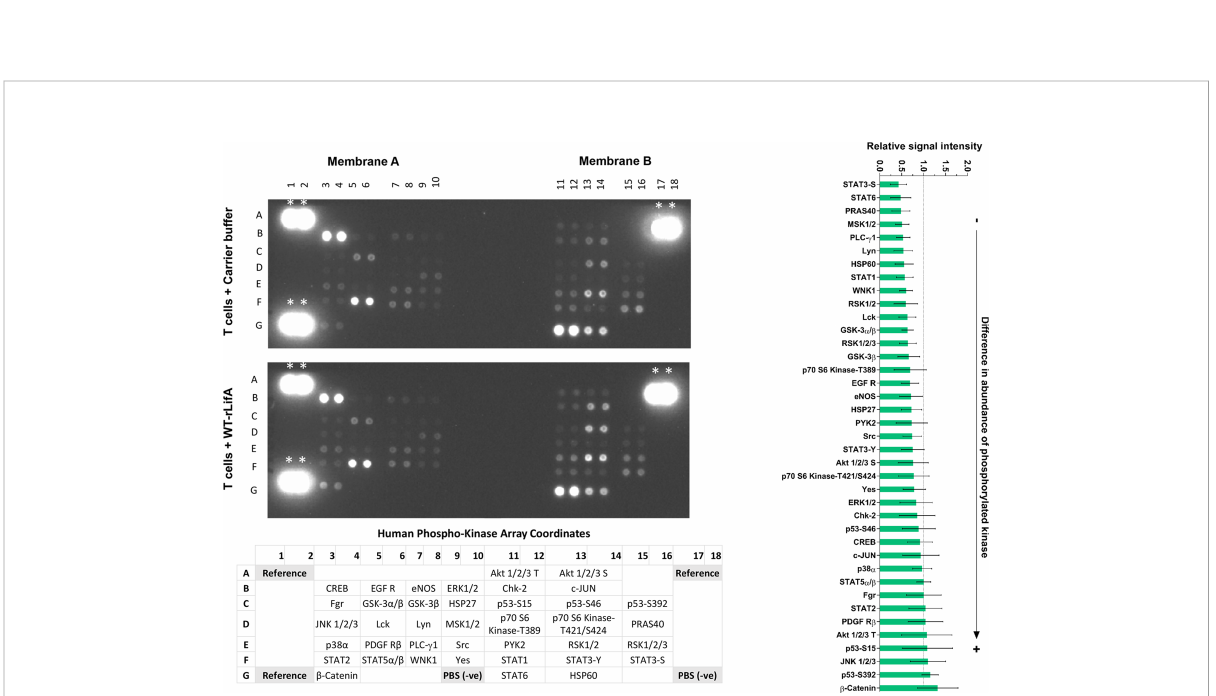
FIGURE 12 Lymphostatin broadly affects the phosphorylation of kinases involved in signal transduction in anti-CD3/anti-CD28-stimulated T cells. Left panel shows immunoblot of signaling phosphokinases in anti-CD3/anti-CD28-stimulated T cells treated with 10 ng/ml of WT-rLifA or untreated (cells with mitogen; no tested protein). Representative data using cells from one donor is shown. The array comprises immobilized antibodies speci fi c for phosphorylated variants of the kinases shown at the bottom of membranes. *indicates as reference spots. Bar graph on the right panel shows relative signal intensity of phosphorylated kinases captured from ant-CD3/anti-CD28-stimulated T cells treated with 10 ng/ml of WT- rLifA. Data represent the mean of 5 independent donors ± S.E.M. Statistical comparison was performed by using Kruskal-Wallis test.